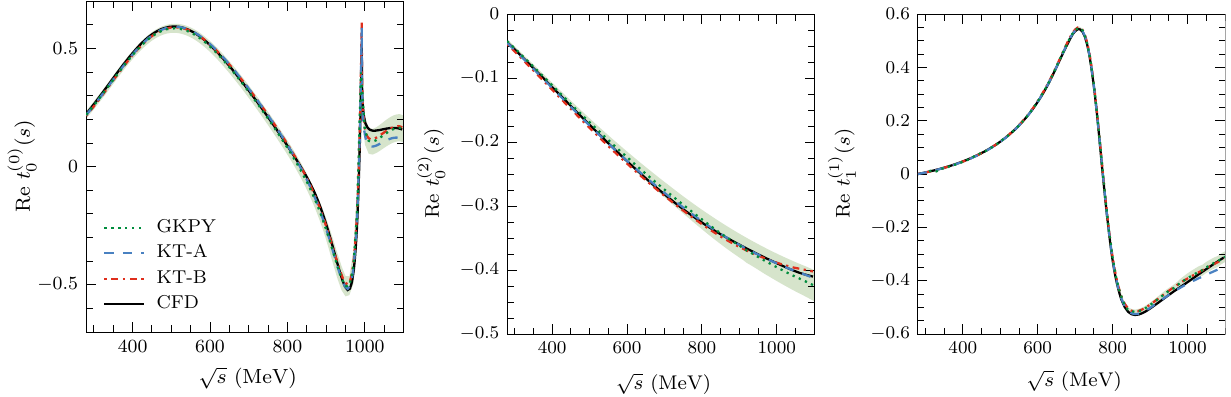
Fig. 2 Same as Fig. 1, but restricted to S - and P -waves, and including the dispersive output (green dotted lines, GKPY) of Ref. [40]. The (green) error band is associated with the GKPY dispersive output, as given in Ref.